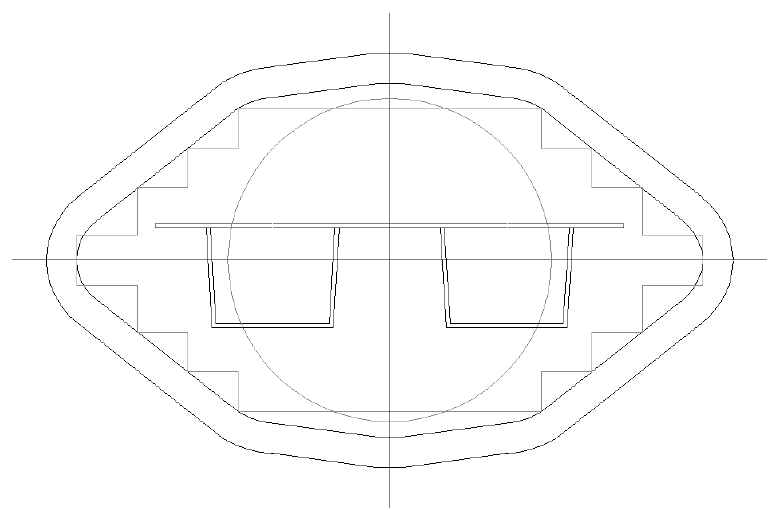
Figure 11. Optimized Panel Section 3 (see Figure 4).